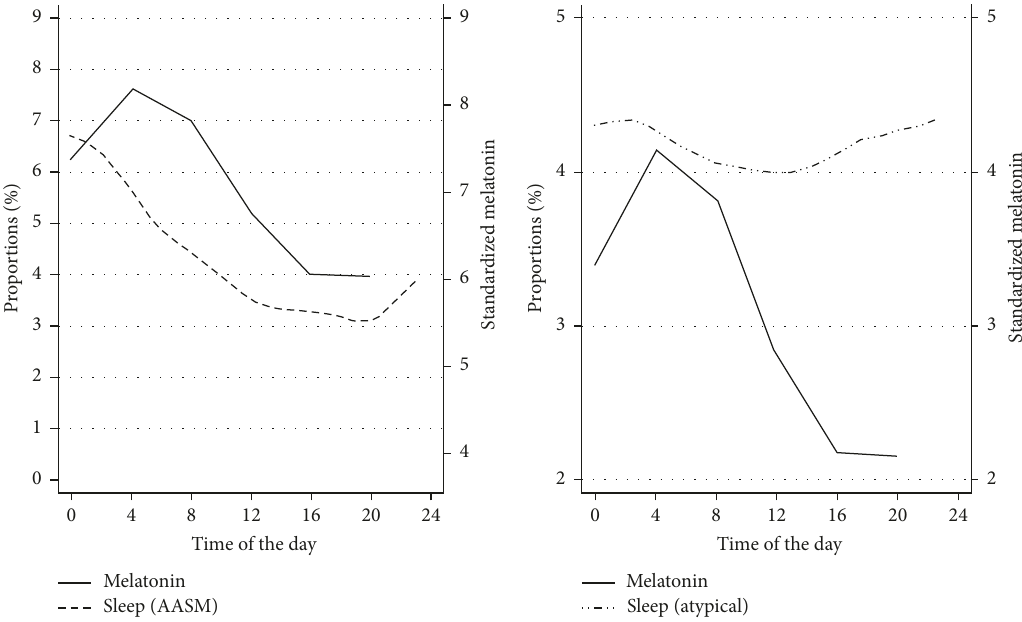
Figure 3: Diurnal variation of sleep and melatonin. Melatonin line represents connected mean melatonin values at each sample point. These values are standardized to sleep proportion values to visualize both curves on the same scale on 𝑦 -axis. Normal sleep (AASM standard) and atypical sleep (Watson’s classification) are plotted as the proportions of sleep (normal sleep + atypical sleep + wake + undefined = 100%) over the 24-hour period together with melatonin to visualize diurnal variation of sleep and